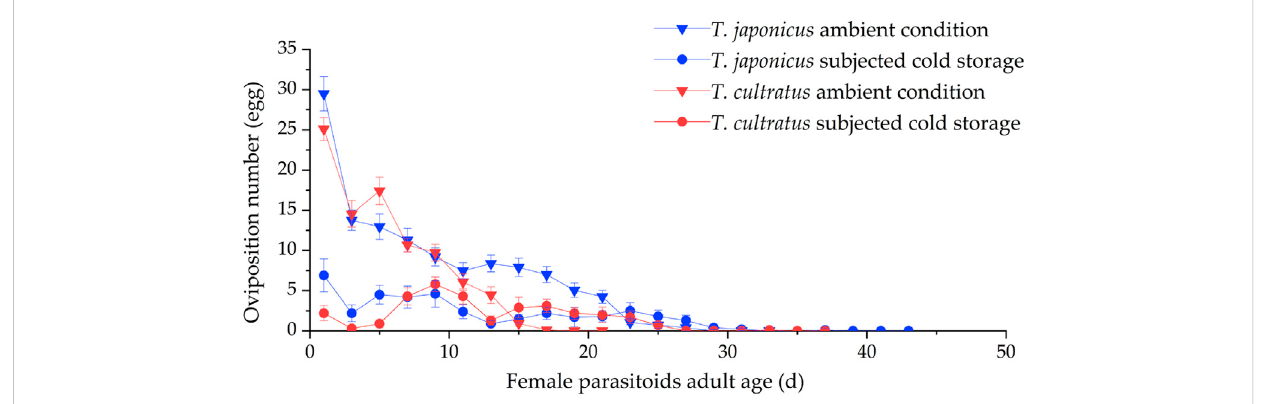
FIGURE 3 Variation in number of ovipositions by T. japonicus and T. cultratus under ambient rearing condition (25 ° C) and after cold storage for 19 weeks at 11 ° C. Values are the mean ± SE.